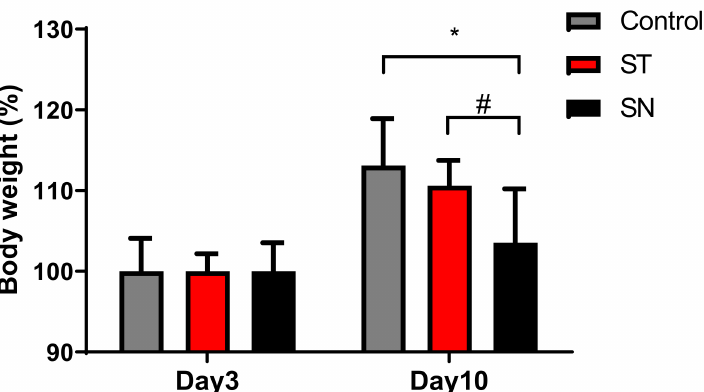
Figure 4. Treatment with EcN prevents body weight gain in C57BL/6 mice. Streptomycin (20 mg/day) was administered to mice in both ST and ST groups on day 1, and only the mice from SN were treated with EcN (1 × CFU) via oral gavage on days 3 and 6. The body weight of each mouse was measured on days 3 and 10. Data are expressed as the means ± SDs ( n = 7). * p < 0.05 vs. control mice and # p < 0.05 vs. ST mice. (EcN: Escherichia coli strain Nissle 1917; CFU: colony-forming units; ST: streptomycin alone-treated group; SN: streptomycin- and EcN-treated group; SD: standard